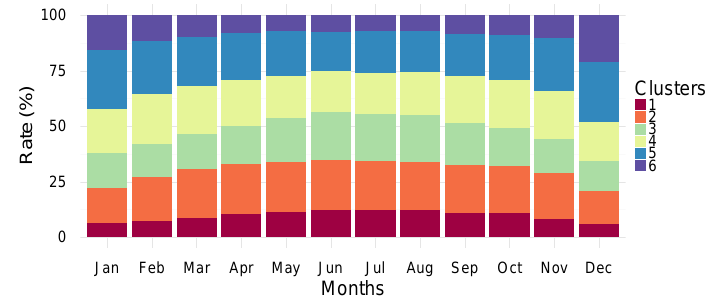
Figure 8. Distribution of clusters by month.